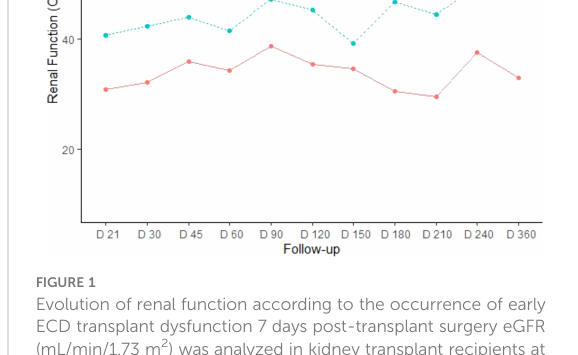
Figure 2B). Median values of Fractalkine/CX3CL1 (Figure 2F)